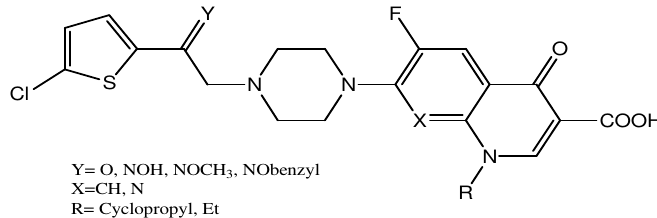
Figure 1 . N -substitueted piperazinyl quinolones with cytotoxic activities